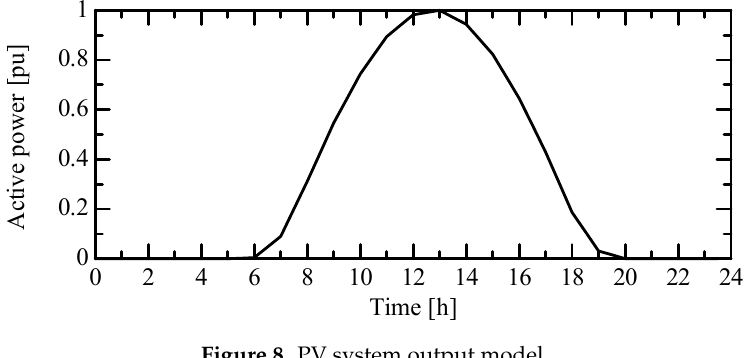
Figure 8. PV system output model.